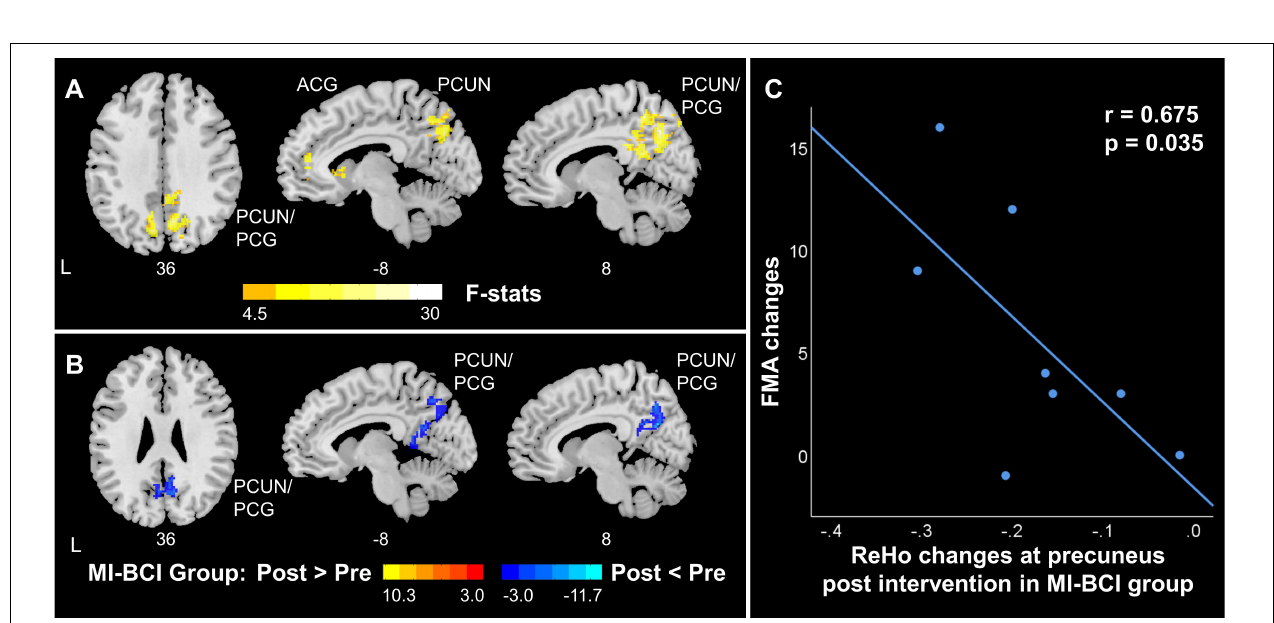
FIGURE 4 | ReHo changes in DMN in stroke patients along with motor function recovery. (A) The interaction effect between group and time. The MI-BCI group and MI-BCI + tDCS group showed divergent intervention effects at DMN. (B) The intervention effect in the MI-BCI group. The MI-BCI group showed decreased ReHo at DMN. No such effect was observed in the MI-BCI + tDCS group. (C) Correlation between FMA changes and ReHo changes in MI-BCI group. A negative correlation was observed between FMA changes and ReHo changes post intervention in the MI-BCI group at precuneus. No such correlation was observed in the MI-BCI + tDCS group. L, Ipsilesional Hemisphere; DMN, Default Mode Network; PCUN, Precuneus; PCG, Posterior Cingulate Gyrus; ACG, Anterior cingulate and paracingulate gyri.